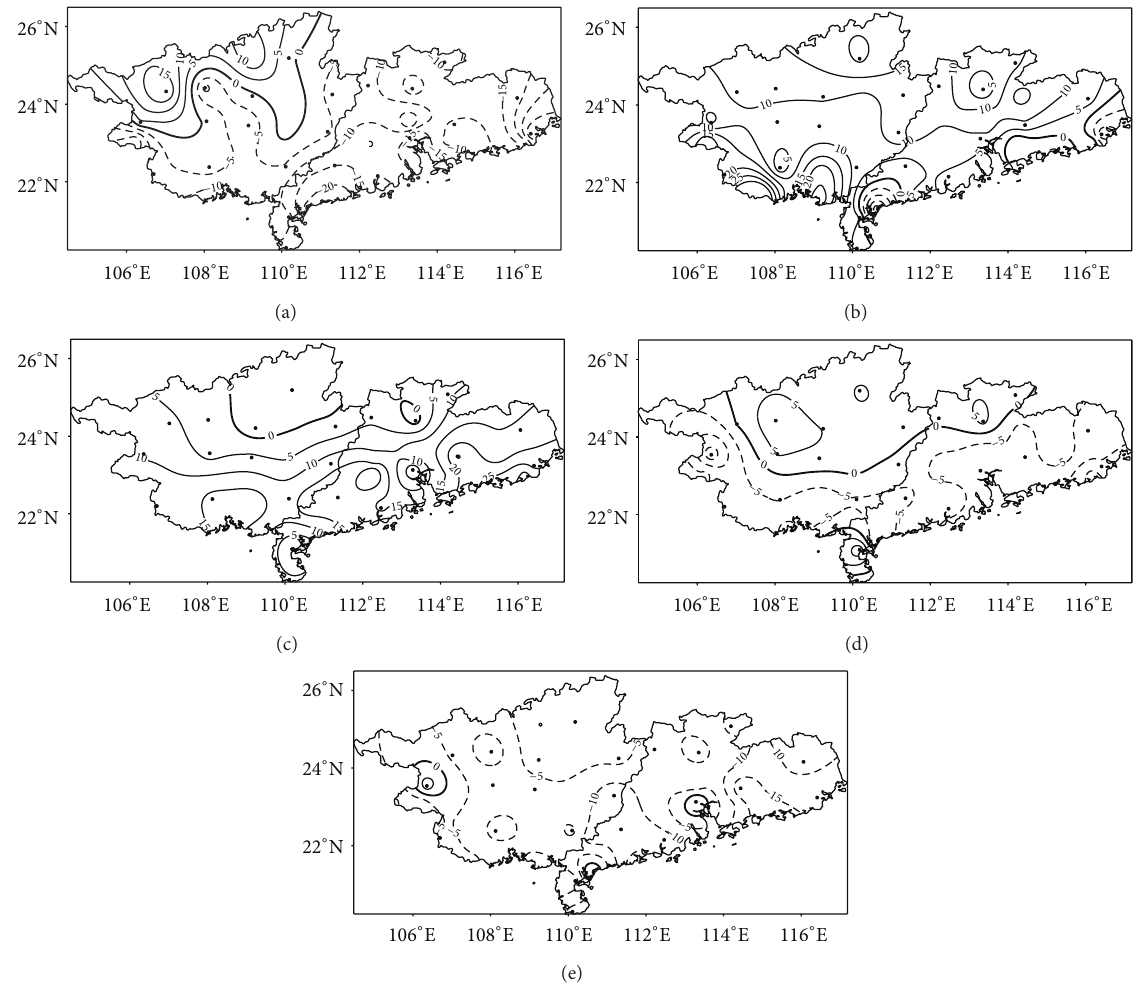
Figure 6: The spring precipitation anomaly percentage in the South China ((a) 1960s, (b) 1970s, (c) 1980s, (d) 1990s, and (e) 2000s).